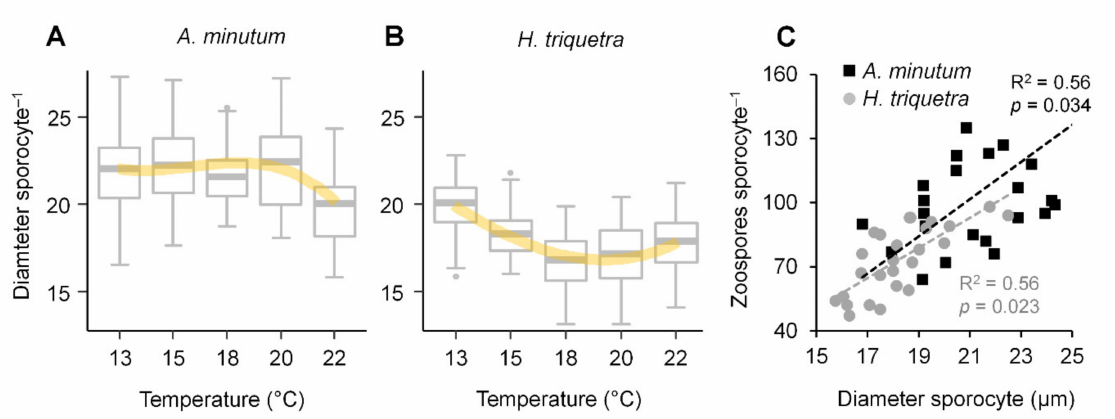
Figure 3. Effect of temperature on late sporocyte diameter in Parvilucifera rostrata RCC2823 infecting the dinoflagellates Alexandrium minimum ( A ) and Heterocapsa triquetra ( B ). Positive relationship be- tween late sporocyte diameter and zoospores produced per infection in Parvilucifera rostrata RCC2823 infecting A. minutum and H. triquetra ( C ).